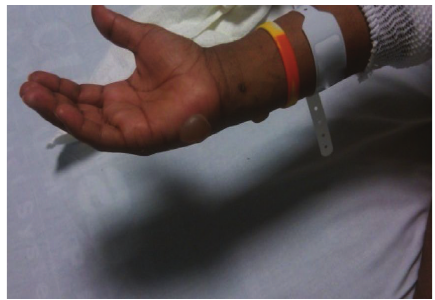
Figure 3: Bulla on the palmar aspect of right